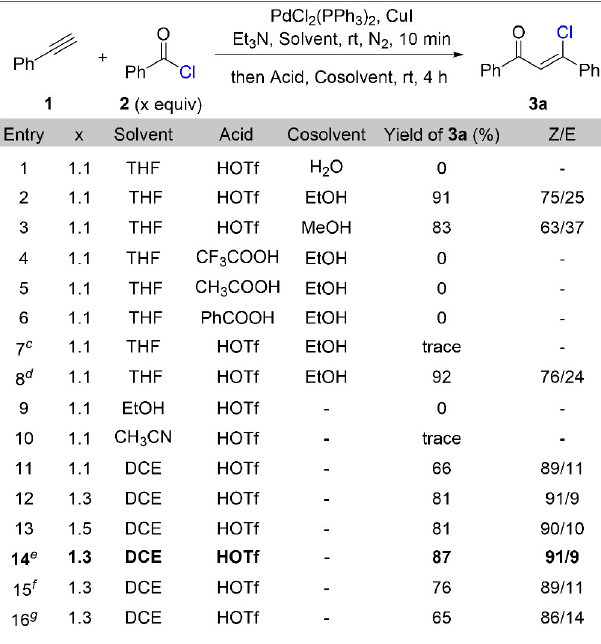
TABLE 1 | Optimization of reaction conditions a , b